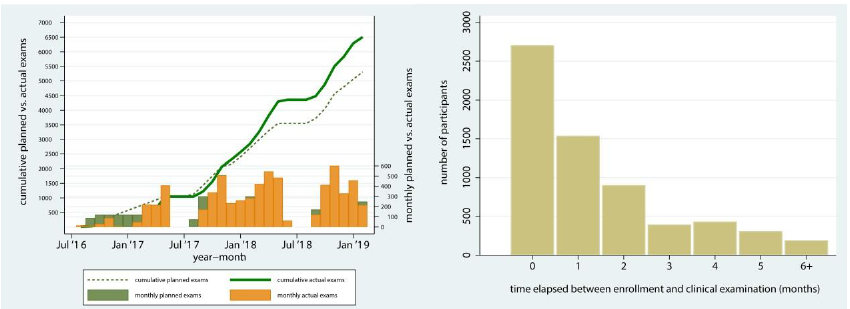
Figure 5. Monthly and cumulative clinical encounters during the 30-month study period and distribution of time elapsed (months) between enrollment and clinical examination in the ZOE 2.0 study, North Carolina, United